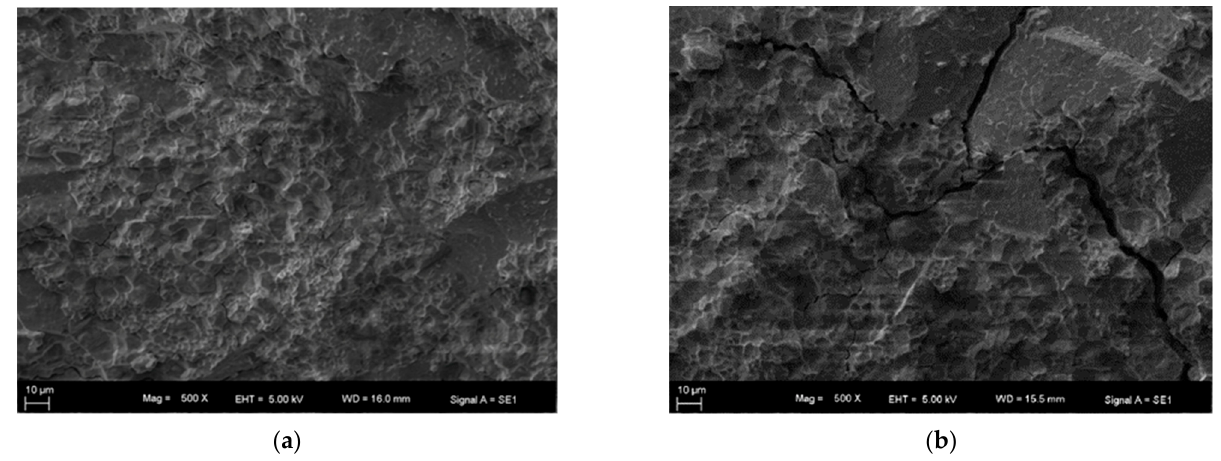
Figure 3. Microstructural comparison of newly harvested rice and rice stored for one year. ( a ) mi- crostructure of fresh rice. ( b ) microstructure of rice stored for one year.